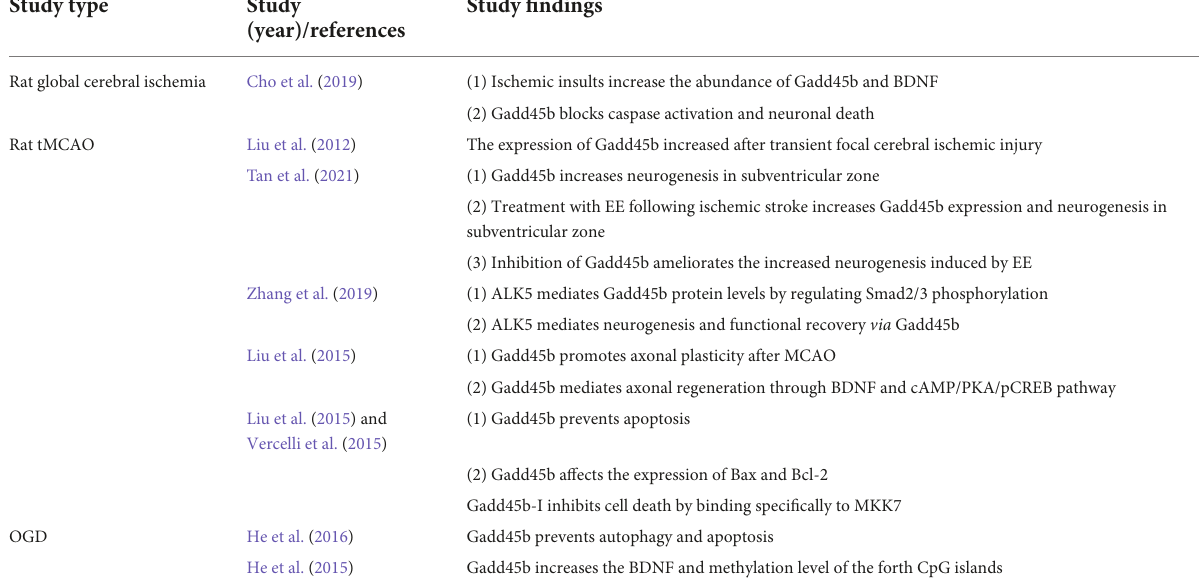
TABLE 1 Studies of growth arrest and DNA damage-inducible beta (Gadd45b) in cerebral ischemia. Study type Study